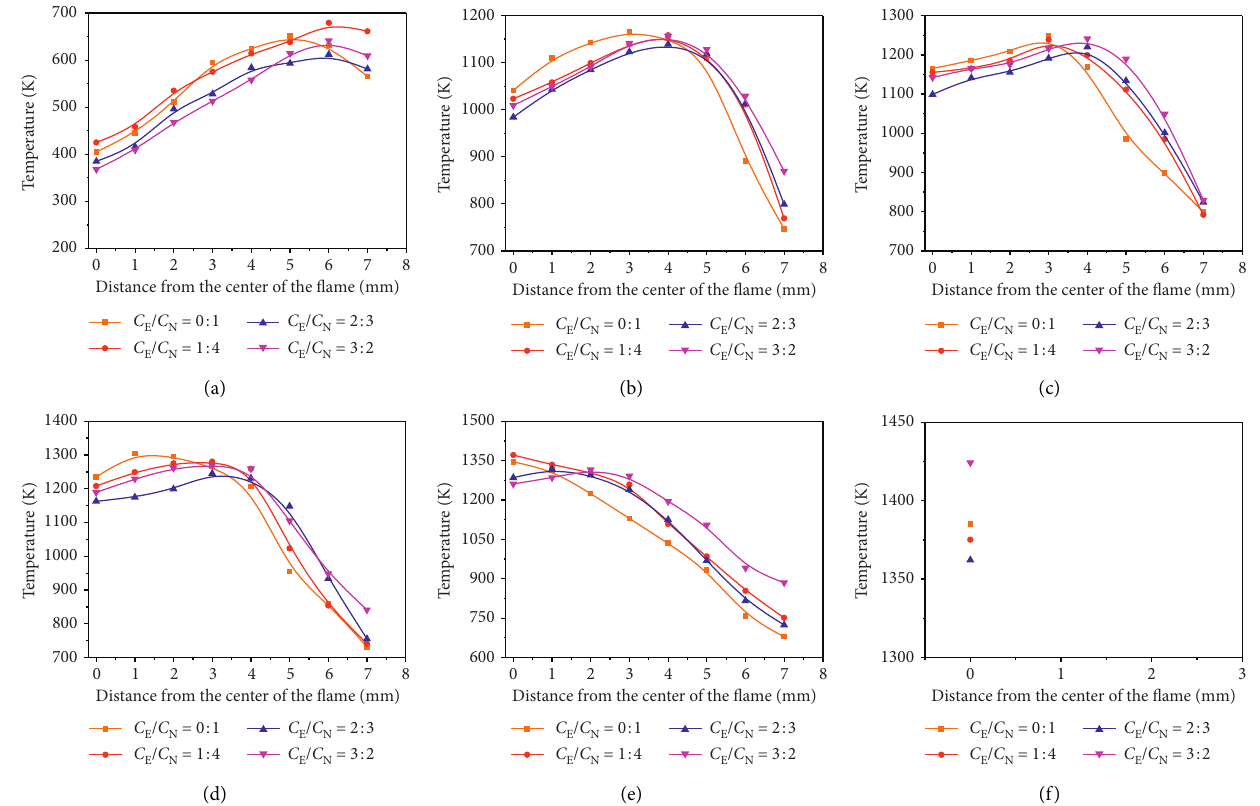
Figure 3: Temperature distribution of flame under different experimental conditions at the same height. (a) HAB � 0cm. (b) HAB � 1cm. (c) HAB � 2 cm. (d) HAB � 3cm. (e) HAB � 4cm. (f) Highest flame